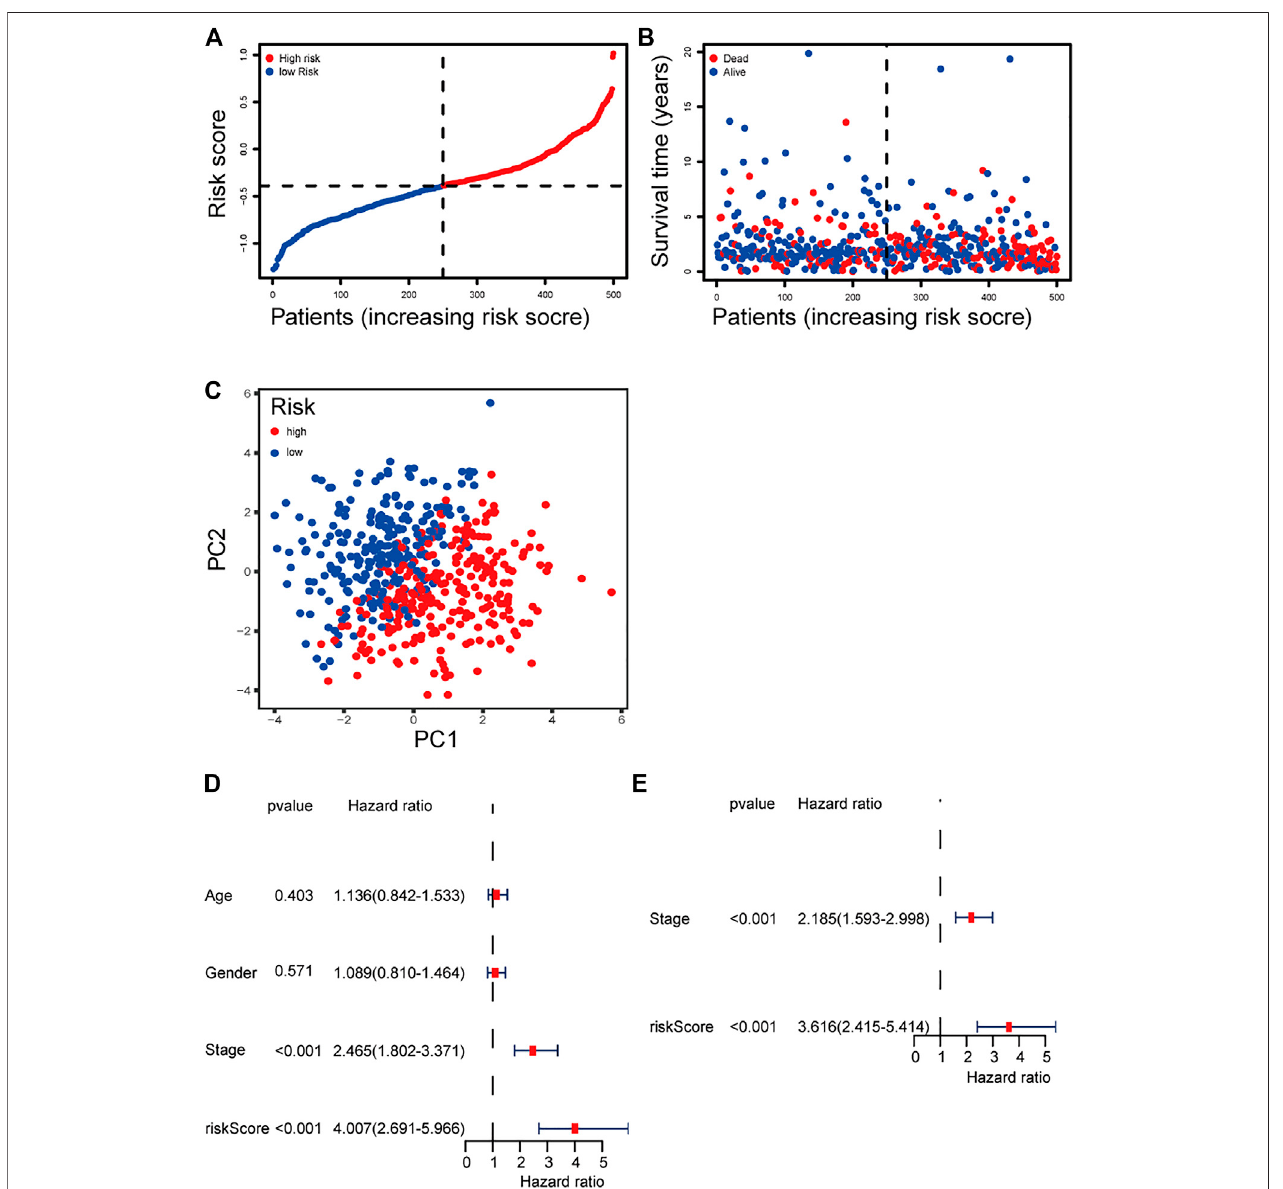
FIGURE 3 | (A) Distribution and median value of the risk scores ofthe ferroptosis-related genes signature. (B) The distributions ofOS status, OS, and risk score of the ferroptosis-relatedgenessignature. (C) PCAplot oftheferroptosis-relatedgenessignature. (D – E) Results oftheunivariate and multivariate Coxregression analyses regarding OS of the ferroptosis-related genes